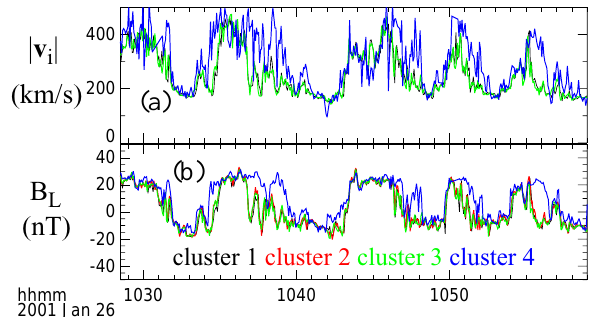
Fig. 7. (a) Overlay of spacecraft 1, 3, and 4 ion flow speed, (b) over- Figure 7. (a) Overlay of Spacecraft 1, 3, and 4 ion flow speed, (b) lay of spacecraft 1–4 magnetic field B L component in the bound- Overlay of Spacecraft 1-4 magnetic field B L component in the ary normal coordinate system with L pointing approximately in the boundary normal coordinate system with L pointing approximately GSM z in the GSM z direction.